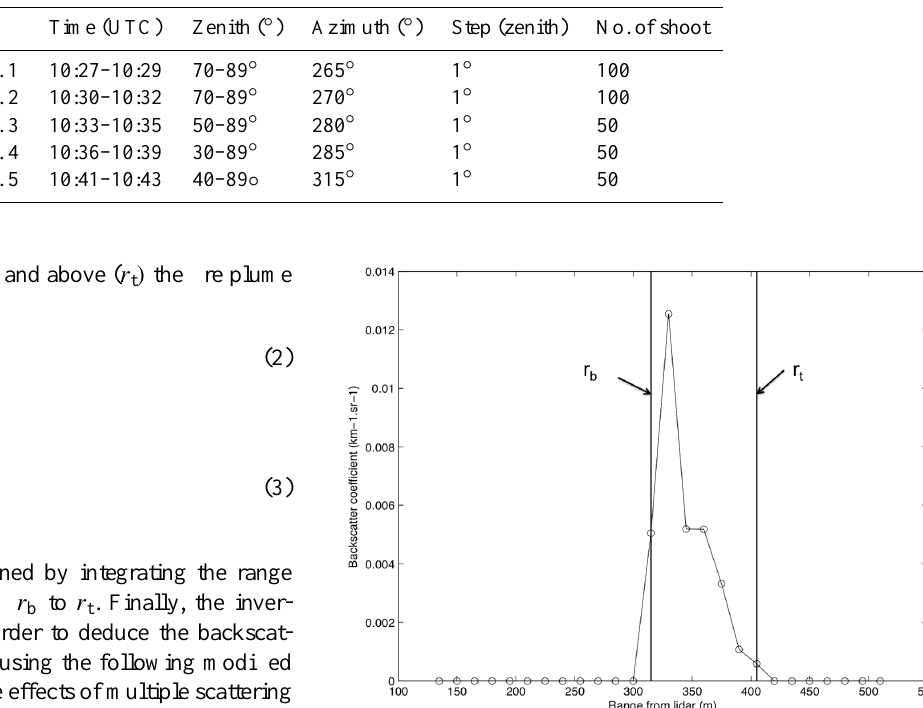
Table 3. Lidar strategy measurements.